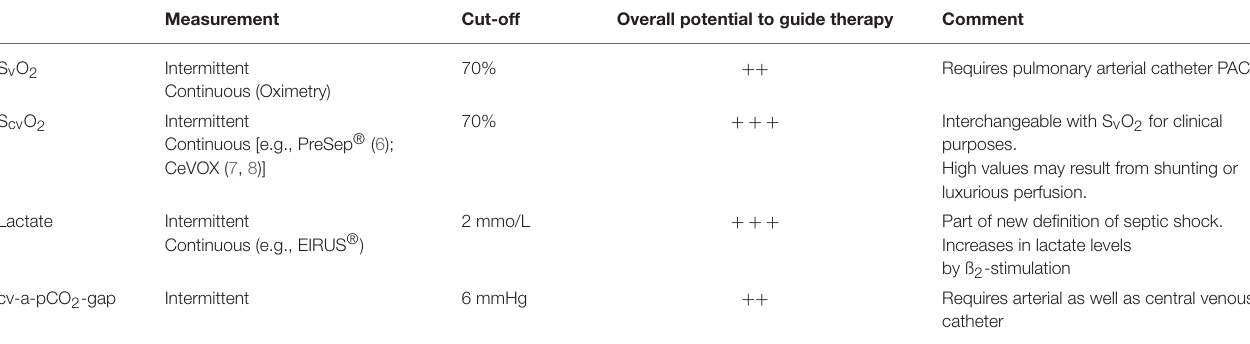
TABLE 1 | Markers of adequacy of macro-circulation. Measurement Cut-off Overall potential to guide therapy